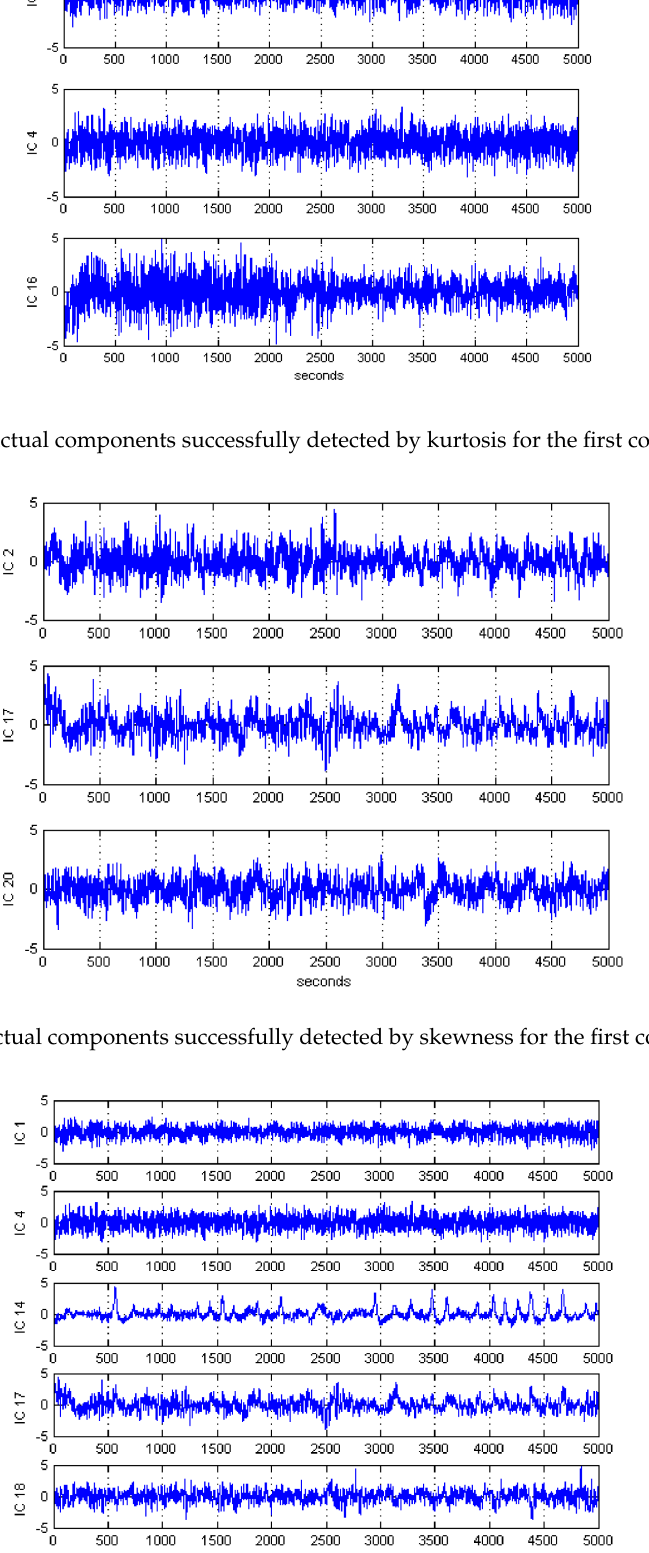
Figure 8. Artifactual components successfully detected by sample entropy for the first control subject.